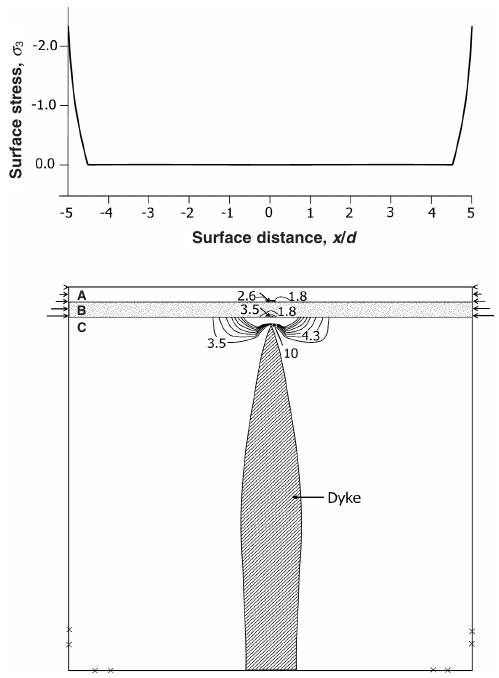
Fig. 19. Boundary-element model of a dyke with a tip at 1 km depth below the surface of a rift zone or a volcanic edifice where the horizontal stress increases linearly (with overburden pressure) from 0 MPa to 20 MPa at 0.8 km depth, as indicated by horizontal ar- rows ( cf. Gudmundsson, 2003). Layer B is soft ( E = 5GPa), whereas the other layers are moderately stiff ( E = 40 GPa). The contours show the values between 1 and 10 MPa of the maximum principal tensile stress. The upper diagram shows that there is no dyke-in- duced tensile stress at the surface above the dyke (the margin stresses are irrelevant because they relate to the non-physical boundary conditions in the model). This is because layer B , which takes up very little ten- sile stress, hinders stress transfer to the surface layer A . The lower diagram shows the tensile stress con- centration at the dyke tip, the maximum value being = 102 MPa ( cf. eqs. (5.1), (5.2) and